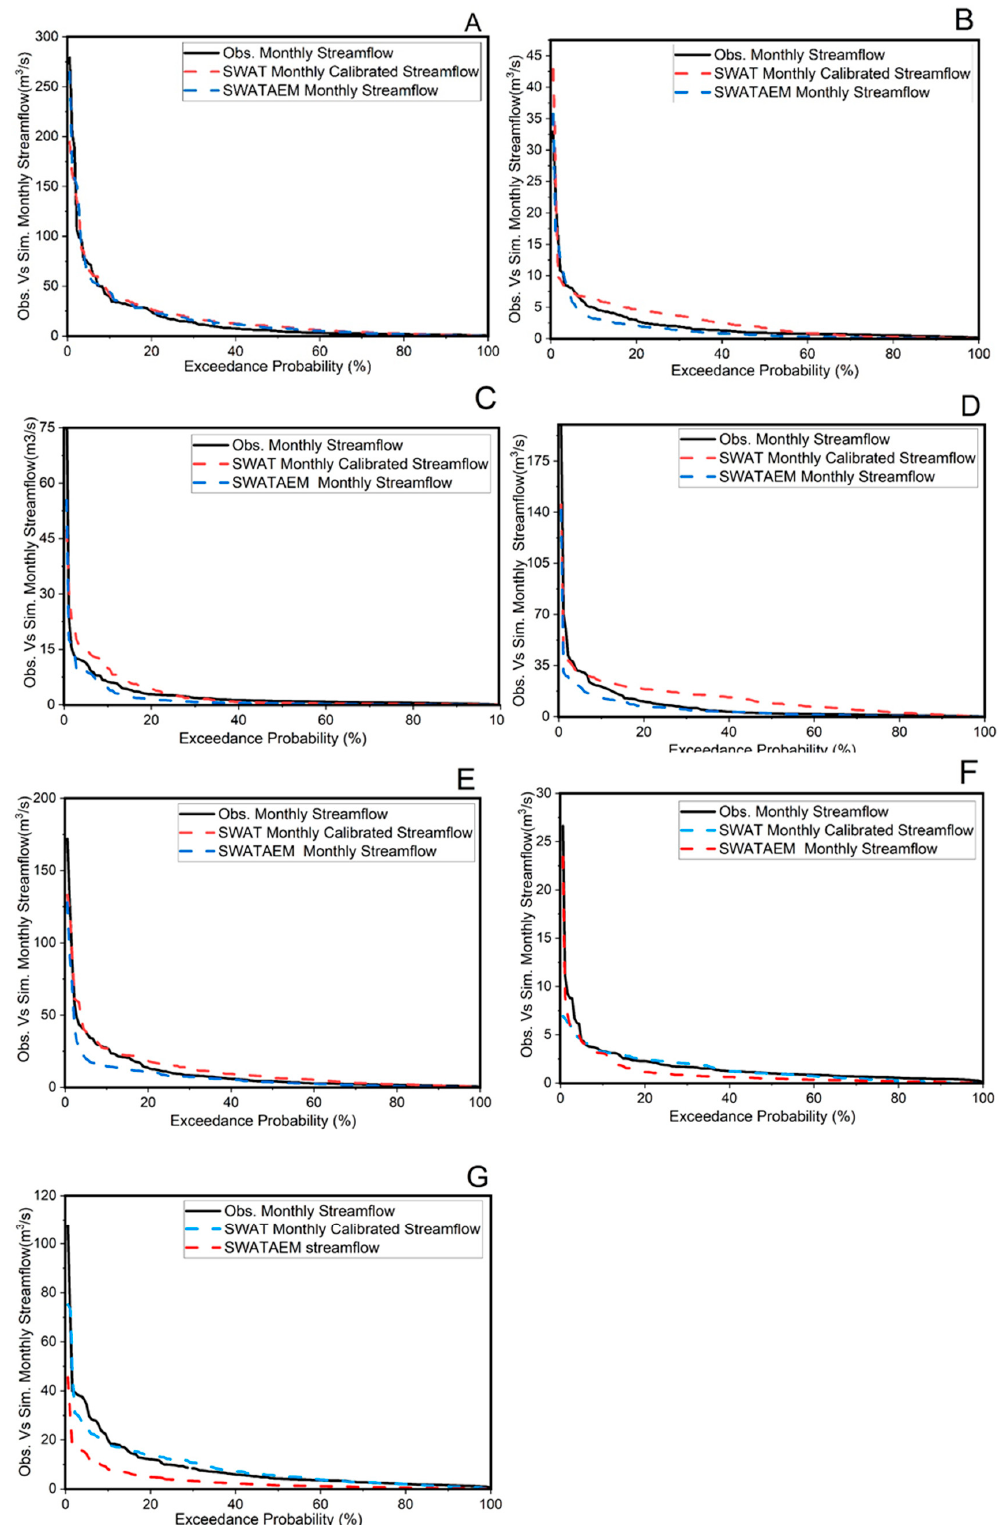
Figure 8. Flow Duration Curve for Observed and Simulated SWAT/SWATAEM stream flow (m 3 /s) for Seven gauge locations ( A ). USGS 08068090, ( B ). USGS 08070500, ( C ). USGS 08071000, ( D ). USGS 08070200, ( E ). USGS 08068500, ( F ). USGS 08068450 and ( G ). USGS 08069000.